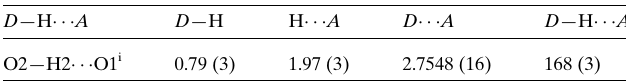
Table 1 Hydrogen-bond geometry (A˚ , (cid:4)